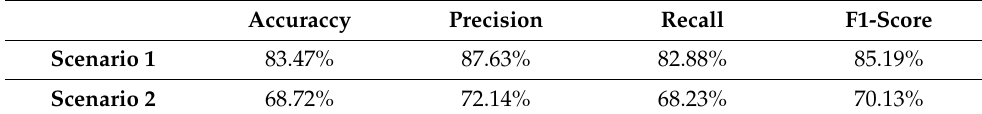
Table 1. Model Performances in Scenario 1 and Scenario 2.